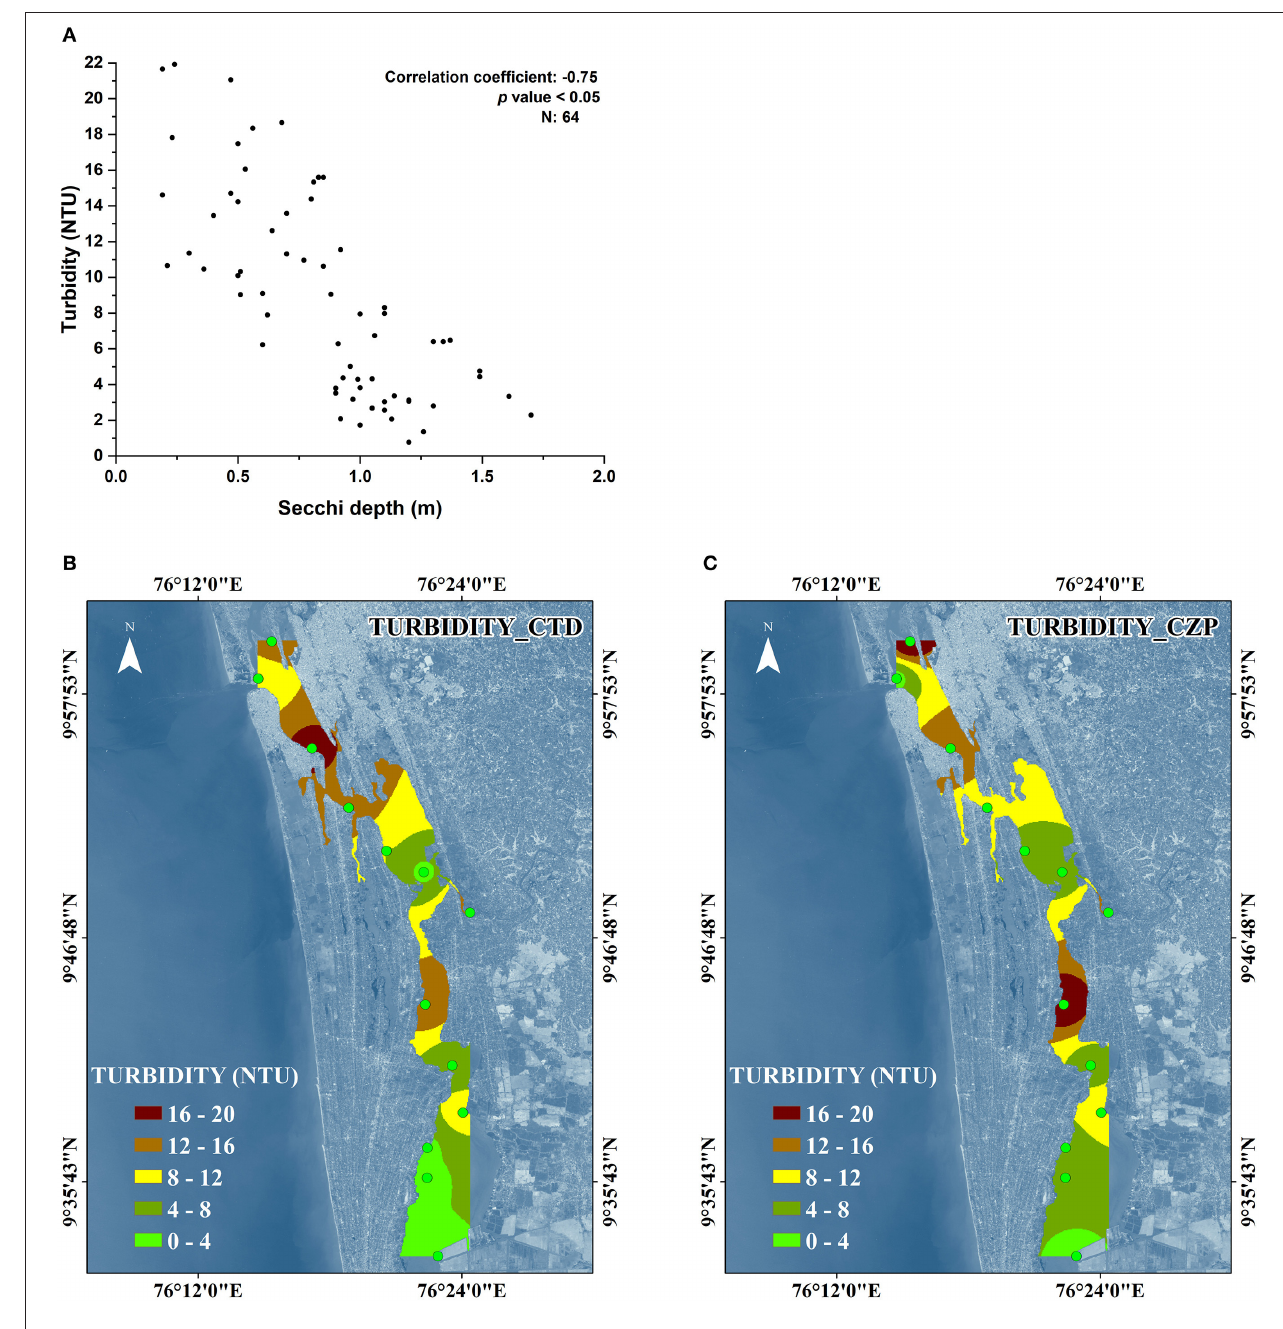
FIGURE 7 | (A) Correlation between Secchi depth measured by citizens and turbidity measured simultaneously using the CTD instrument by scientists. (B) Spatial turbidity profile of Vembanad Lake based on the CTD data. (C) Spatial turbidity profile of Vembanad Lake based on the turbidity derived from Secchi depth data, using the model of Anon (2012). Average of data collected from August 2019 to December 2020 are